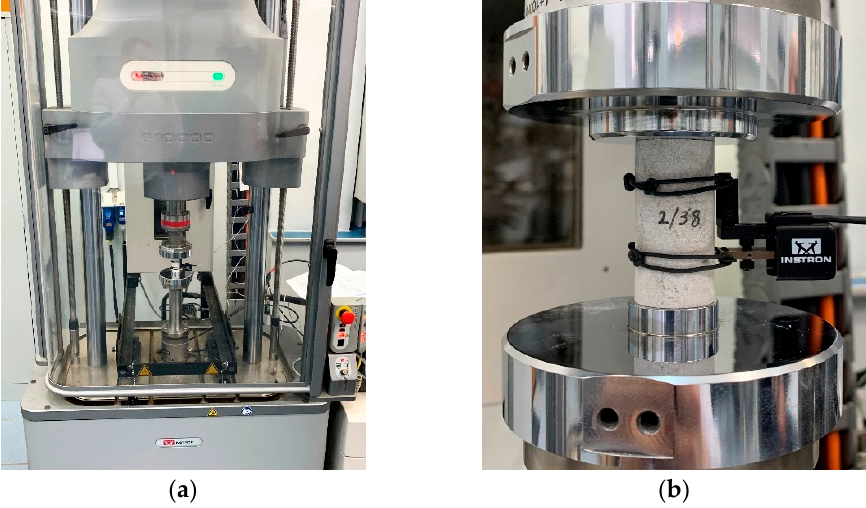
Figure 12. Instron ElectroPuls E10000 Test System with Test Sample: ( a ) general view of the instal- lation; ( b ) dry sample 2/38 installed between the loading plates with an Instron 2620-603 dynamic strain gauge.